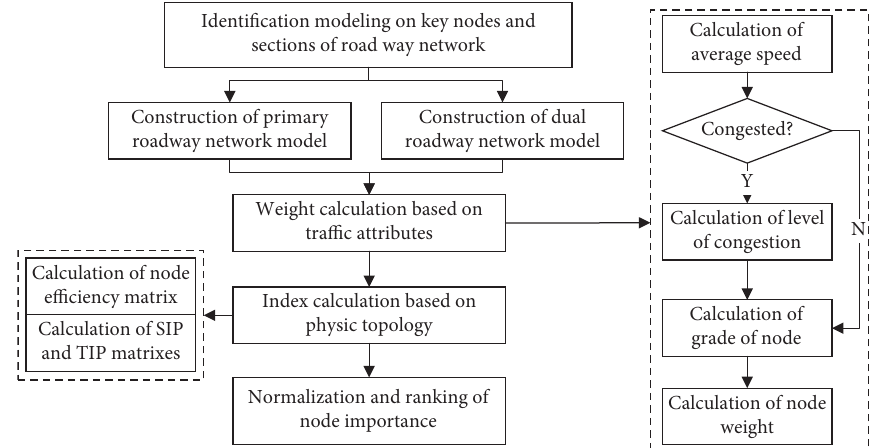
Figure 3: Identification process of key nodes and sections of the roadway network.